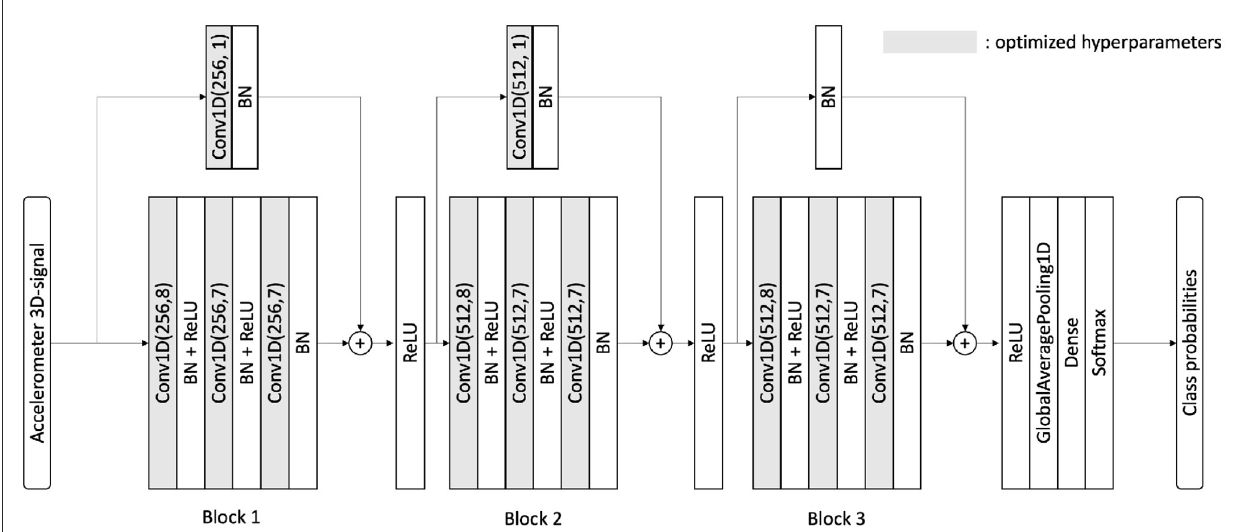
FIGURE6 Neural architecture for our optimized Resnet. This is similar to both binary and multi-class classifications. The number of filters and the kernel sizes are different from the original architecture from Ismail Fawaz et al. (13). BN, batch-normalization; Conv1D, convolution 1D; ReLU, rectified linear unit; Conv1D(F, K), conv 1D with F filters and kernel size K.